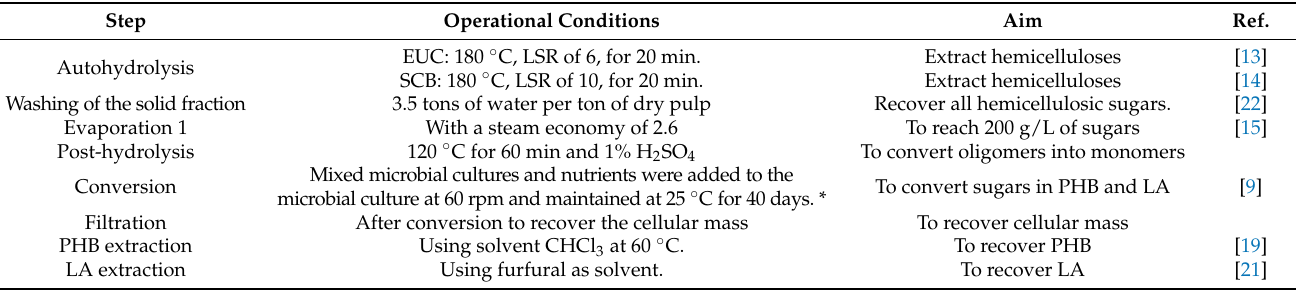
Table 2. Operational conditions for the evaluated processing of the liquid